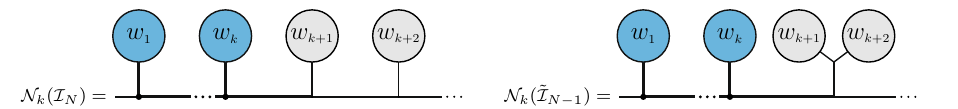
Fig. 2 Example of parent-child relation between open loops. The parent N -point diagram I N and the child ( N − 1 ) -point diagram ˜ I N − 1 share the first k segments (blue blobs). Thus N k ( I N , q ) and N k ( ˜ I N − 1 , q ) are identical and need to be constructed only